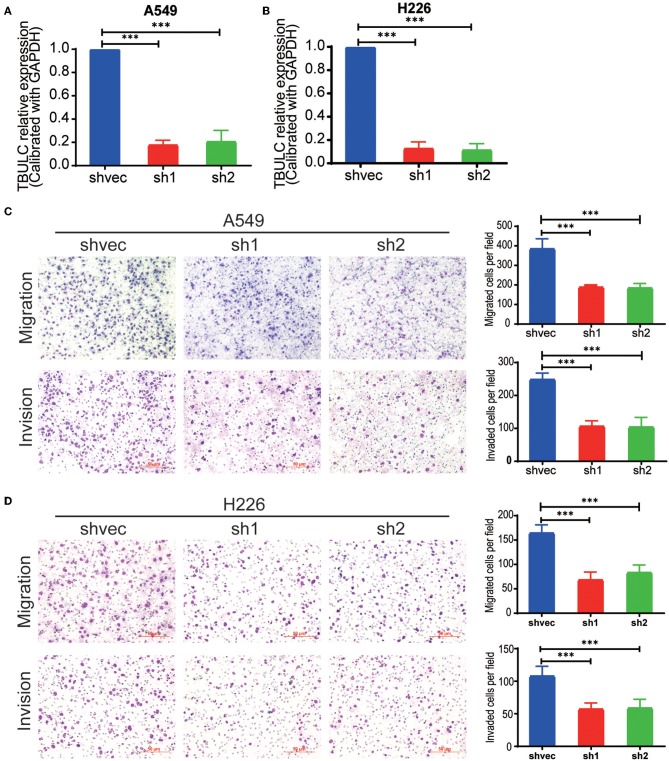
TBULC knockdown inhibited cell migration and invasion in vitro. (A,B) The expression level of TBULC in stable TBULC knockdown or mock vehicle control-transfected (A) A549 and (B) H226 cell clones. (C,D) The migration and invasion ability of TBULC knockdown (C) A549 and (D) H226 cell clones, as detected by the Transwell assay. The numbers of migrating and invading cells were compared between the groups. The data are shown as the mean ± SD. ***p < 0.001.